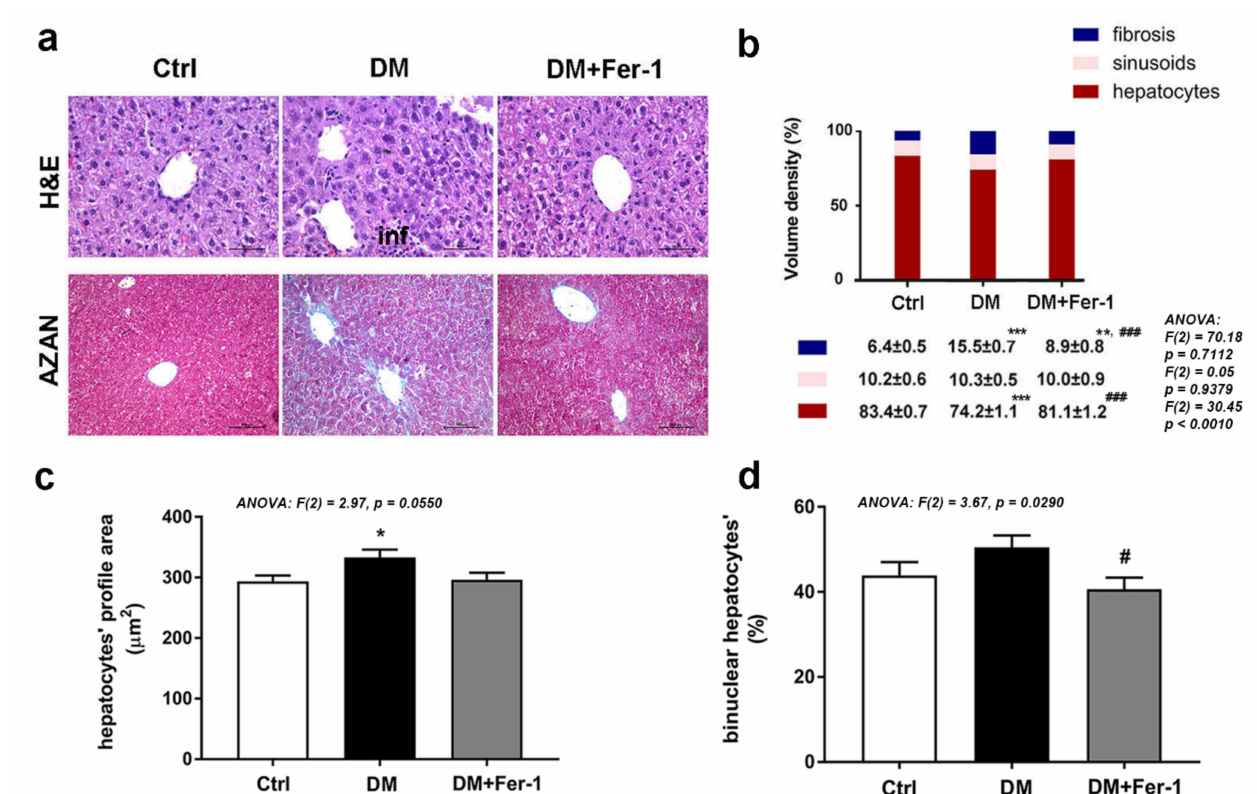
Figure 1. Microscopic analysis of liver tissue of control (Ctrl), diabetic (DM), and diabetic Fer-1- treated (DM + Fer-1) animals. ( a ) Hematoxylin and eosin (H&E) and AZAN trichrome staining; scale bars: H&E—50 µ m, AZAN—100 µ m, inf—infiltration. ( b ) Volume density of hepatocytes, sinusoids, and fibrosis. ( c ) Hepatocytes profile area. ( d ) Proportion of binuclear hepatocytes. Values presented as means ± SEM. Statistical significance: compared with the Ctrl group (*), * p < 0.05, ** p < 0.01; *** p < 0.001; DM vs. DM + Fer-1 comparison (#), # p < 0.05; ### p <